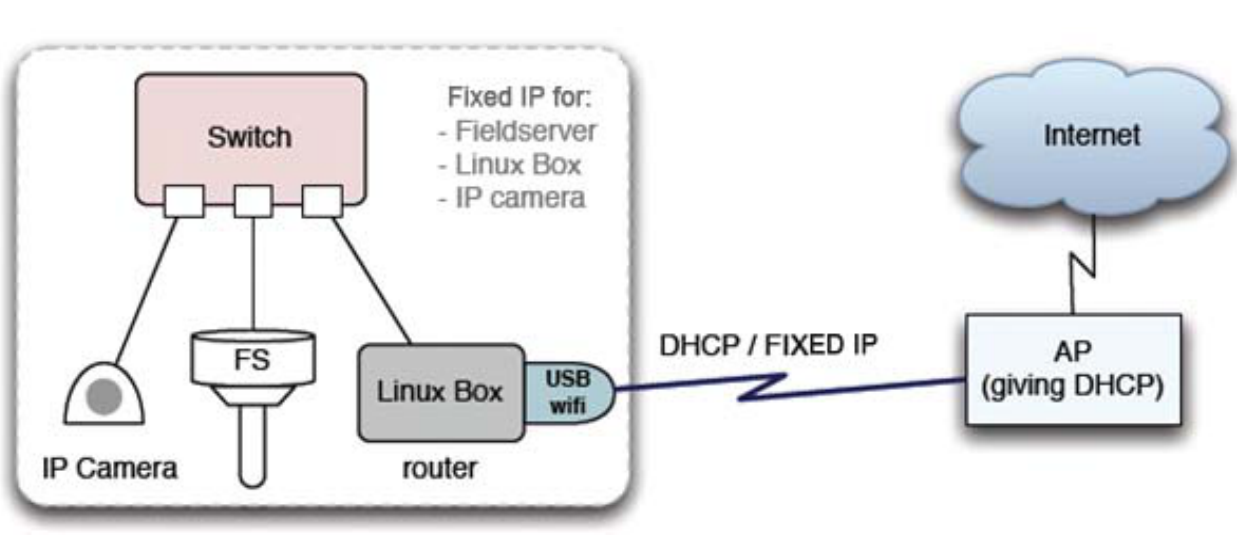
Figure 4. Typical Network